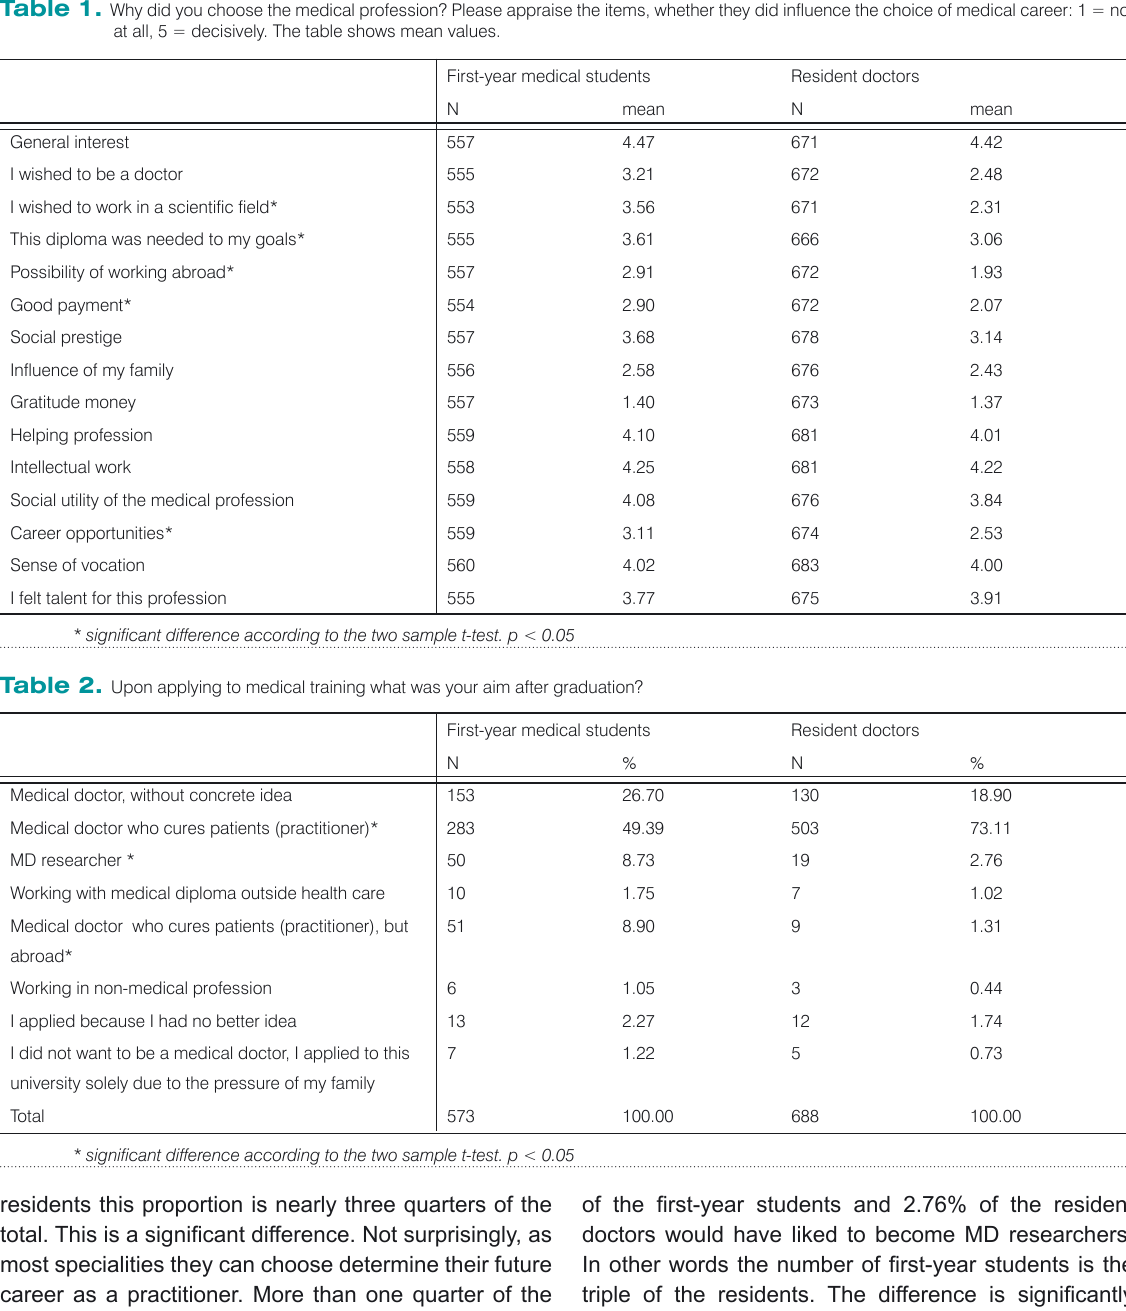
Table 1. Why did you choose the medical profession? Please appraise the items, whether they did influence the choice of medical career: 1 = not at all, 5 = decisively. The table shows mean values.